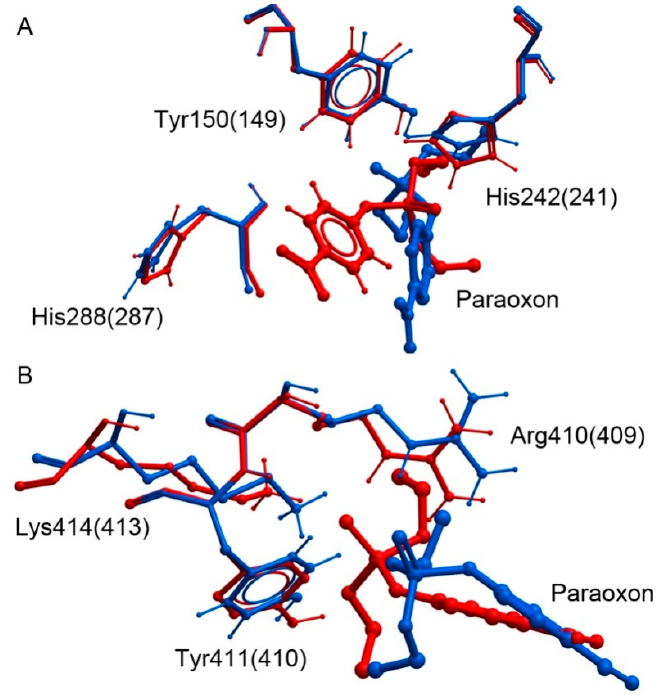
Figure 3. The result of molecular docking of paraoxon into the sites Tyr150 (149) ( A ) and Tyr411 (410) ( B ) of human (blue) and bovine (red) serum albumin.